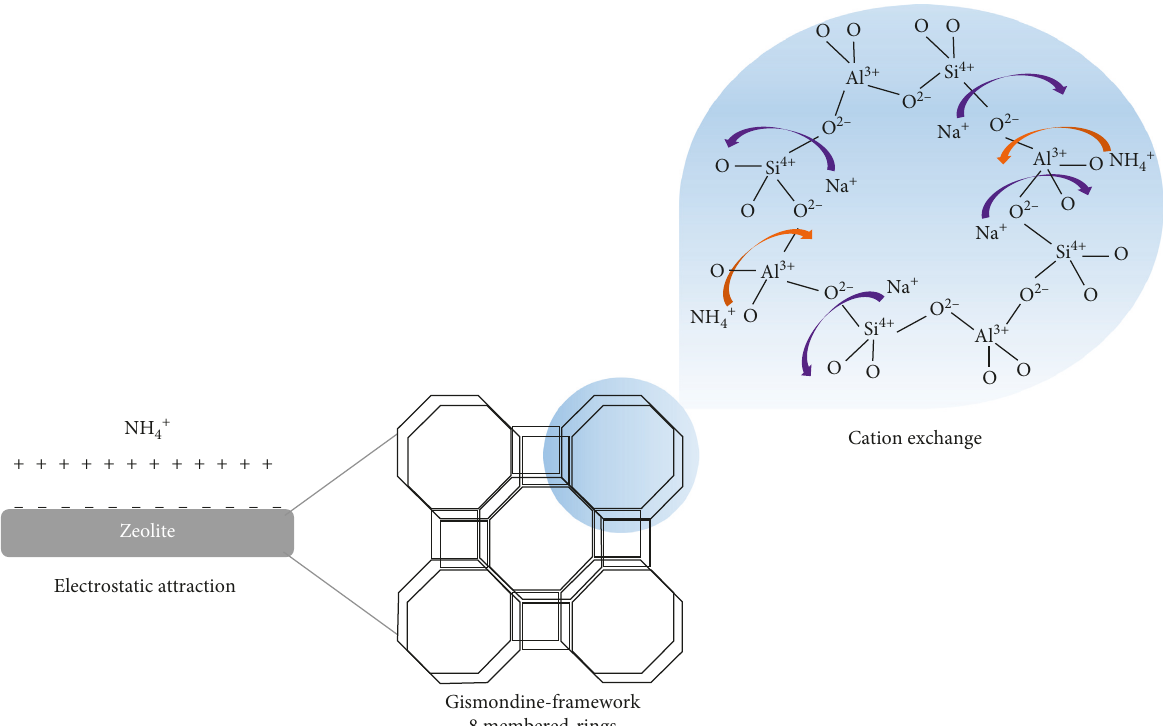
Figure 5: Adsorption mechanism through the cation exchange between the extra-framework cations (Na + ) of the Al-waste-NaP1 zeolite and the ammonium cations (NH 4+